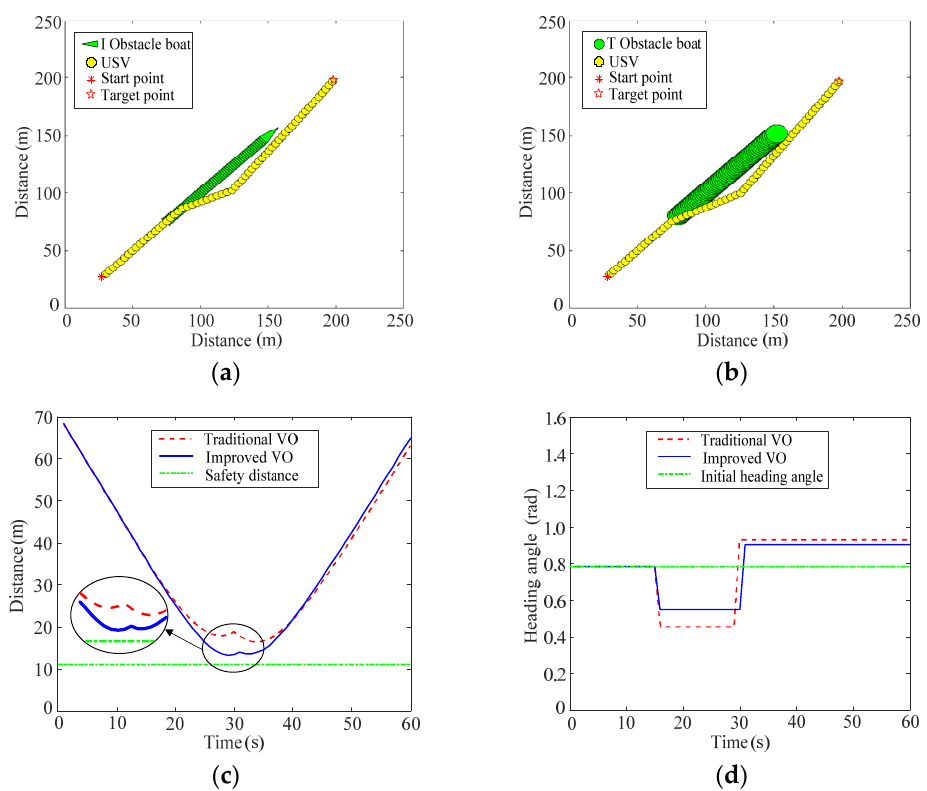
Figure 9. Simulation comparison of the overtaking scene: ( a ) improved VO path simulation; ( b ) traditional VO path simulation; ( c ) relative distance comparison graph; ( d ) USV heading angle comparison chart. Table 2. Simulation data of traditional VO for a single ship.